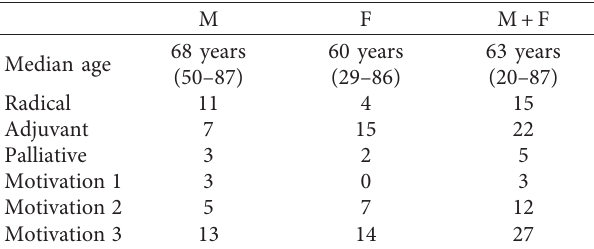
Table 3: Description of patients who delayed radiotherapy.